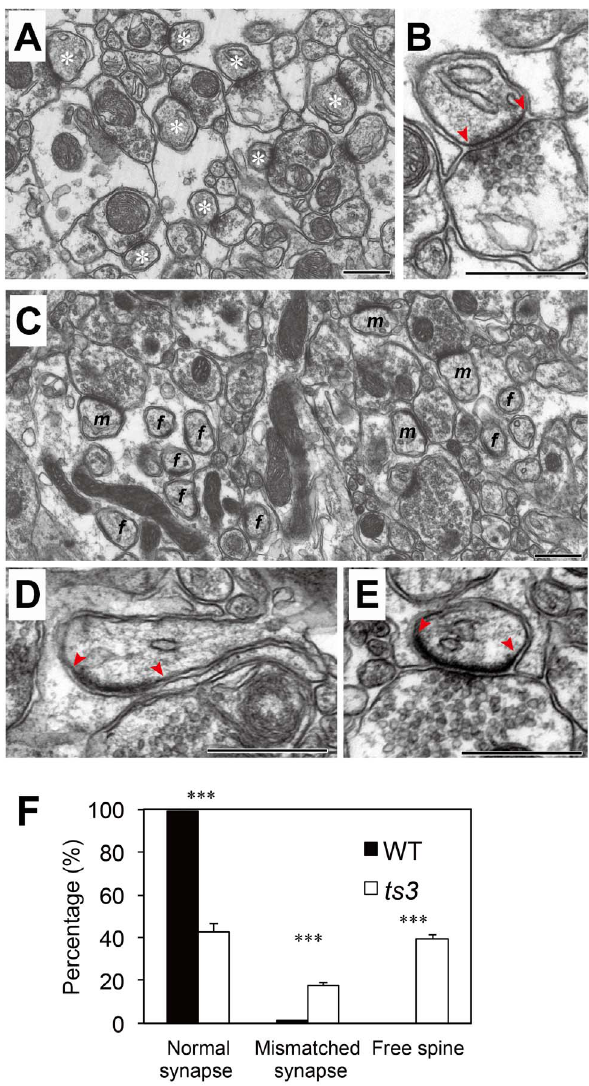
Figure 8. Free spines and mismatched PF-PC synapses in ts3 mutant cerebella. (A-E) Conventional electron microscopy in control (A, B) and ts3 mutant (C-E). A) Asterisks indicate PC spines contacting with PF terminals. B) Higher magnification image of a normal spine in WT. C) Letters f and m indicate free spines and mismatched PF–PC synapses, respectively. High-power images of free spine (D) and mismatched synapse (E). Note that PSD, as indicated between two arrowheads, is well-matched with the synaptic terminal in normal control (B). In contrast, the free spine and mismatched synapse do not have any contact with PF synaptic terminal (D) or has a significantly longer PSD (E), respectively. Scale bars, 500 nm. F) Percentage of normal synapses, mismatched synapses, and free spines in ts3 and WT cerebella. Majority of spines observed in ts3 cerebella were either mismatched or free spines. *** P ,